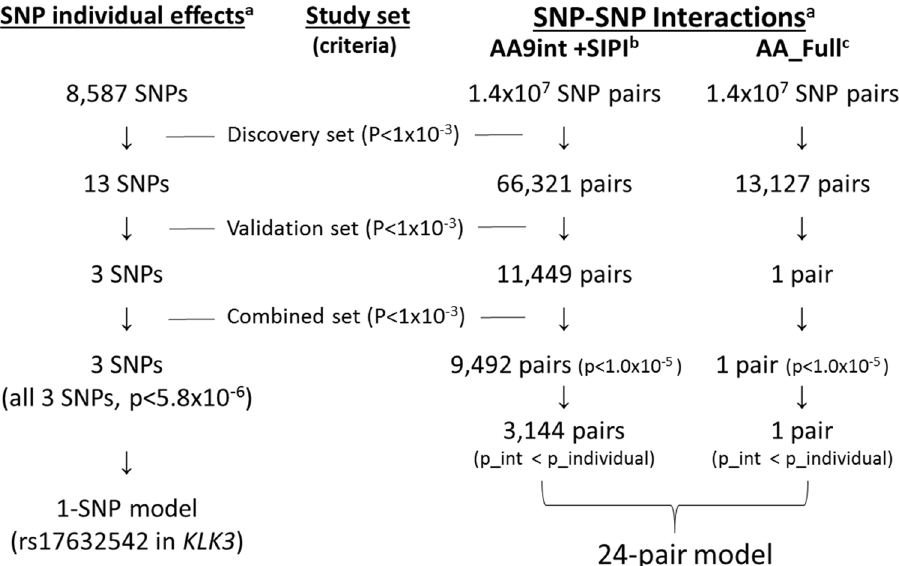
Figure 1. Selection procedure of SNPs and SNP–SNP interaction pairs associated with prostate cancer aggressiveness. a P < 5.8 × 10 –6 is based on Bonferroni correction; candidate SNPs for interaction analyses: 5345 SNPs; 3 SNPs are rs17632542, rs62113212, and rs2569735 in KLK3 . b For SNP interactions, the 2-stage AA9int + SIPI was applied. Using AA9int, 66,619 pairs were selected with a P < 10 –3 in the discovery set, then 66,321 pairs were selected in the second stage using the SIPI approach. SIPI was applied for the validation and combined set analyses. AA9int Additive–Additive 9 interaction-model approach, p_individual p-value of individual SNP effect, p_int p-value of interaction, SIPI SNP interaction pattern identifier, SNP single nucleotide polymorphism. c AA_Full Additive–additive full interaction